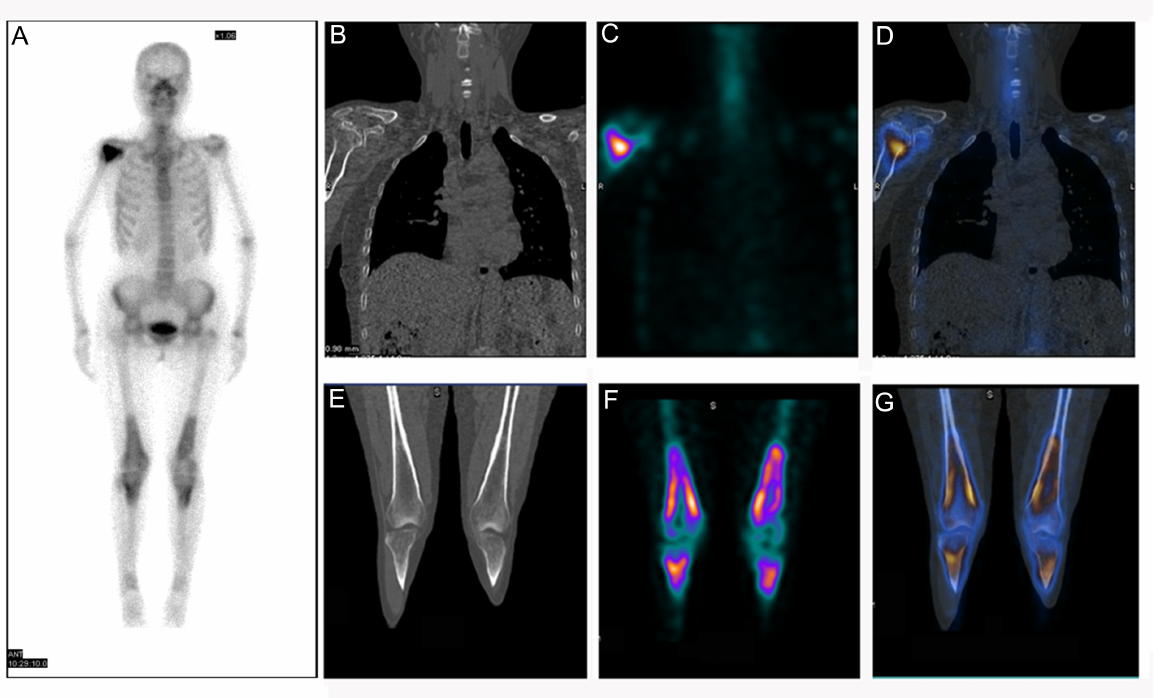
Figure 3. Patient 3: ( A ) 99m Tc-MDP bone scan demonstrated symmetric uptake of radiotracer around both knee joints as well as abnormal tracer uptake in the right humeral head. ( B – D ) Coronal CT image revealed “Double line sign” accompanied by increased tracer uptake under articular surface of the corresponding humeral head. ( E – G ) CT, SPECT and fusion image of the patient’s bilateral tibiae showed abnormal tracer uptake with seemingly normal CT